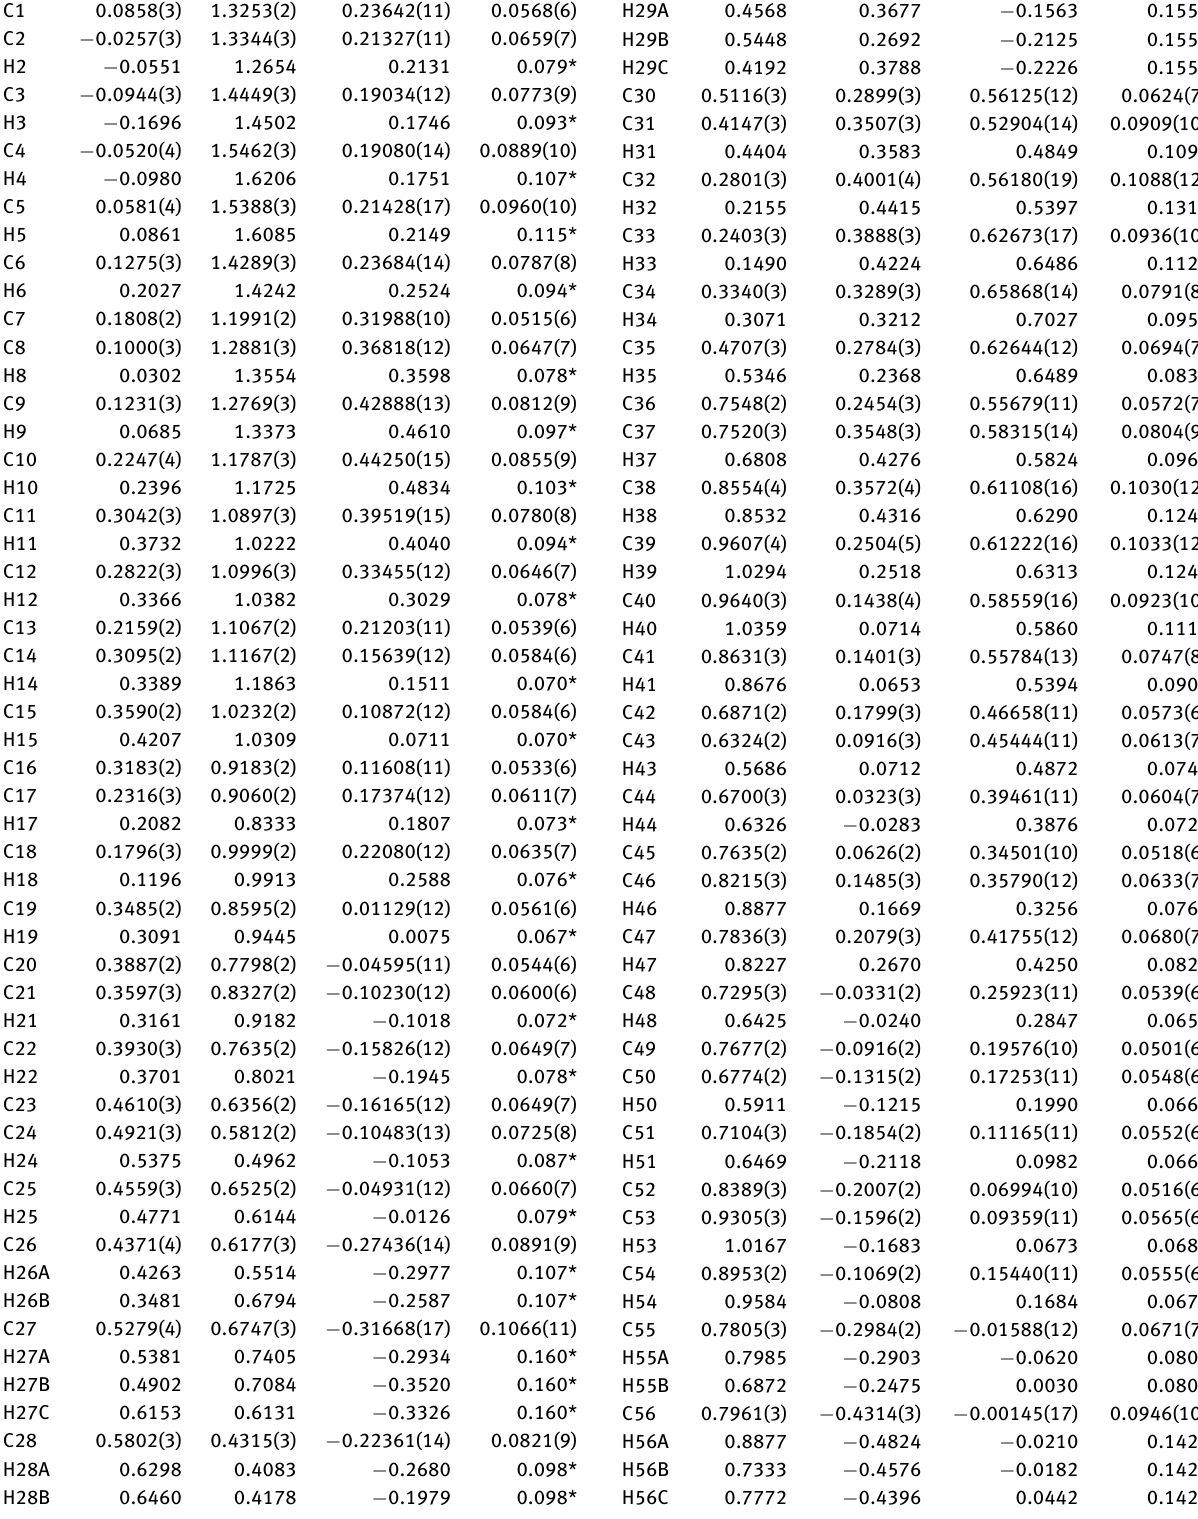
Table 2: Fractional atomic coordinates and isotropic or equivalent isotropic displacement parameters (Å 2